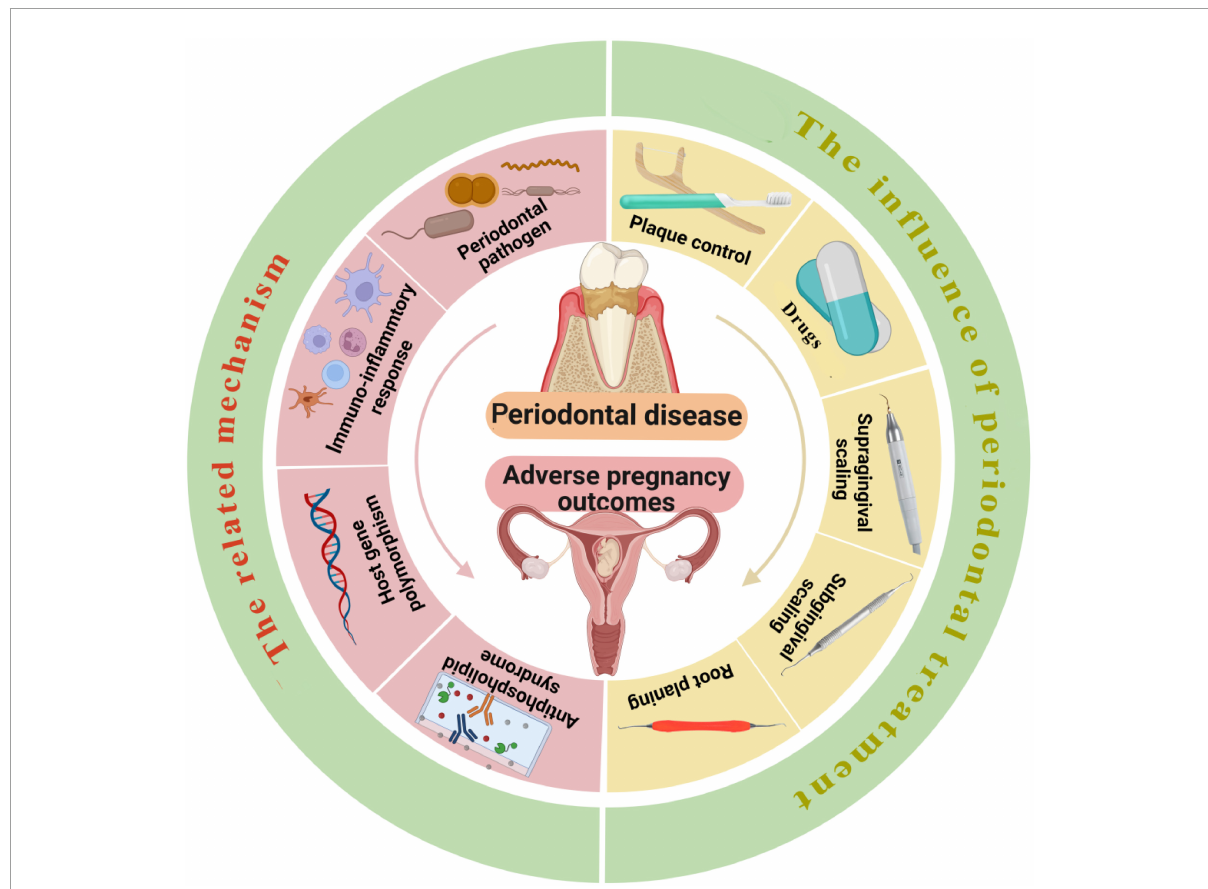
FIGURE1 The left side of the picture shows the mechanisms related to periodontal disease leading to adverse pregnancy outcomes, including periodontal pathogen infection, the changes in the level of inflammatory mediators, host immune response, gene polymorphism, and APS with elevated anticardiolipin antibodies. The right side of the picture shows the effect of periodontal treatment on adverse pregnancy outcomes, the intervention methods include plaque control, application of drugs, supragingival scaling, subgingival scaling and root planning. Reasonable intervention of periodontal diseases during pregnancy is beneficial to the physical and mental health of patients and can reduce the mother-to-child transmission of periodontal pathogens. The ideal time for periodontal treatment is the second trimester (14–27 weeks), if intervention for infection is absolutely necessary, emergency treatment can be performed throughout pregnancy. Created with